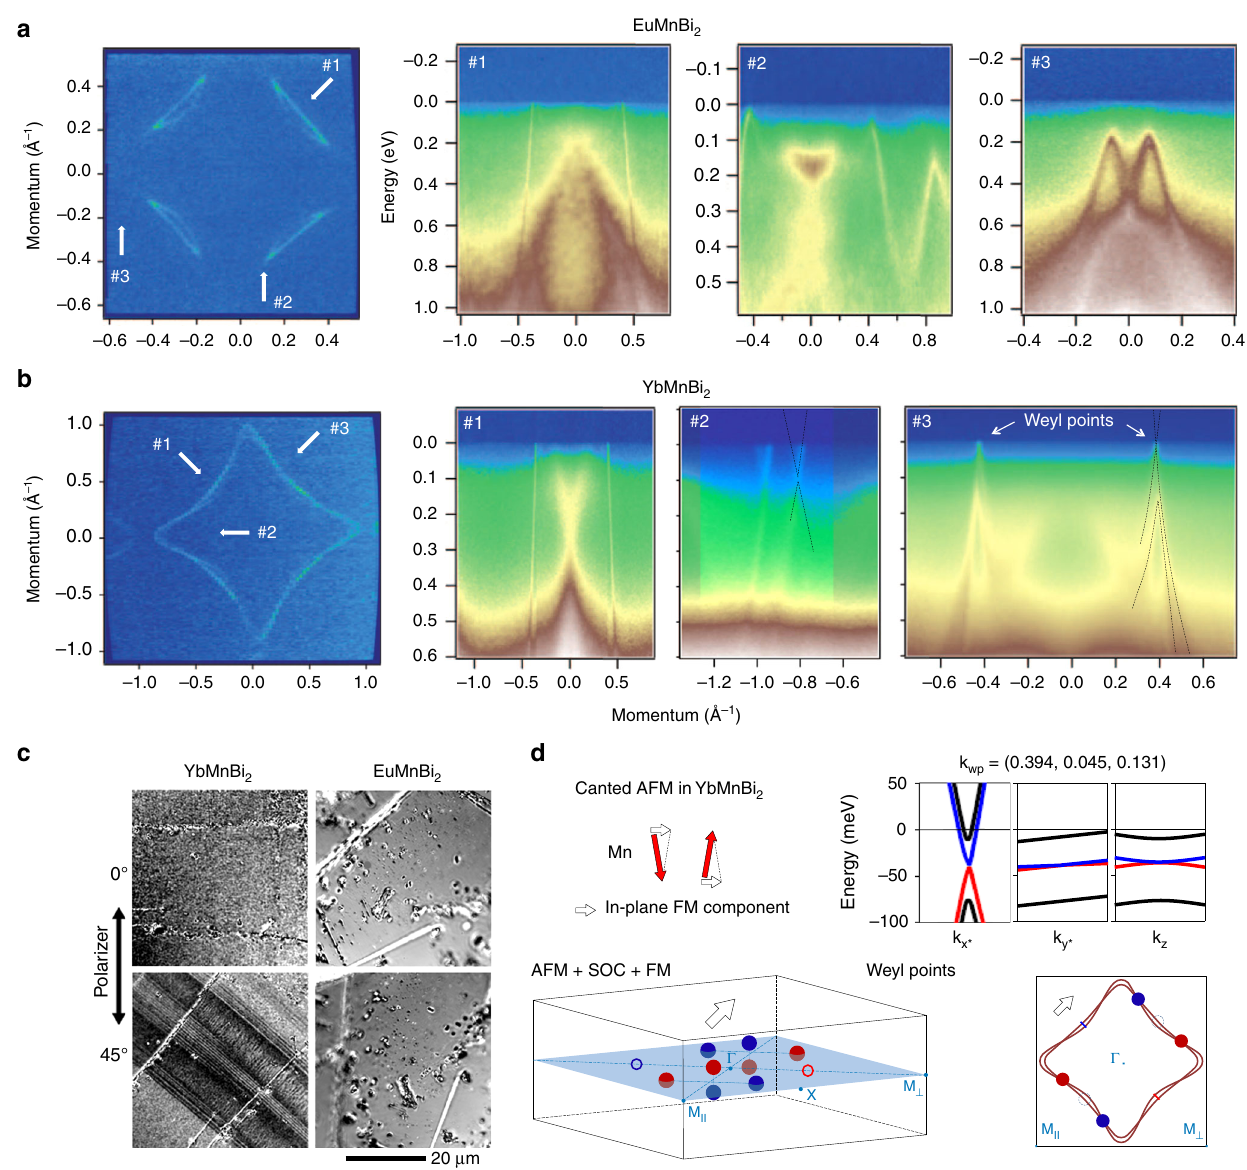
Fig. 2 Experimental electronic structure of EuMnBi 2 and YbMnBi 2 and evidence for canting. a Fermi surface map of EuMnBi 2 . White arrows with numbers indicate the directions along which the spectra in the panels to the right have been recorded. Data are taken using 27 eV photons (cut #1 at 44 eV). No Dirac crossings are seen in this case. b Same as ( a ), but for YbMnBi 2 . Zero momentum in panel with the cut #2 ( h ν = 80 eV) corresponds to the BZ center. Dashed lines in the panel with cut #3 are guides to eye representing splitting of the degenerate bands due to TRS breaking. Crossings of these bands near the Fermi level are Weyl points. c Magneto-optical images of the YbMnBi 2 (left) and EuMnBi 2 (right) crystals, observed under conditions of the Voigt effect at perpendicular light incidence. A domain contrast can only be seen on the YbMnBi 2 material, proving the presence and the absence of magnetic moment canting in YbMnBi 2 and EuMnBi 2 , respectively (see text). d Schematic results of the band-structure calculations taking into account the canting (10°) resulting in an in-plane ferromagnetic component along the (1,1,0) direction. k x* and k y* are the directions perpendicular to and along the Fermi surface contour,